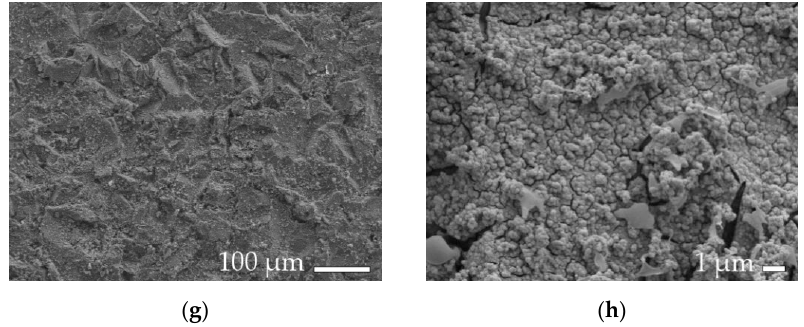
Figure 8. SEM images of the surface textures obtained using the immersion method: ( a ) AS sandblasted at 0.5 MPa for 10 s, ( b ) AS after immersion in cerium nitrate and stearic acid, ( c ) AS sandblasted at 0.5 MPa for 10 s, ( d ) AS after immersion in cerium chloride and stearic acid, ( e ) Al-Mg sandblasted at 0.4 MPa for 10 s ( f ) after immersion in cerium nitrate and stearic acid, and ( g ) Al-Mg sandblasted at 0.5 MPa for 15 s and ( h ) after immersion in cerium chloride and stearic acid.